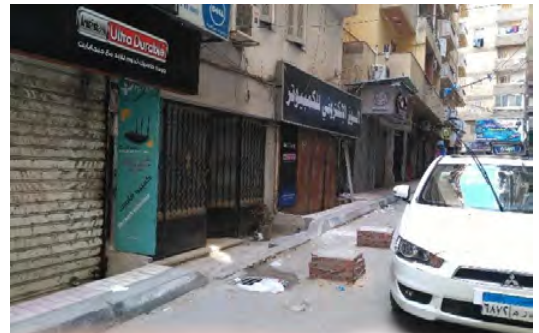
Figure 2. Infringement on the street to prevent car parking (The researcher,